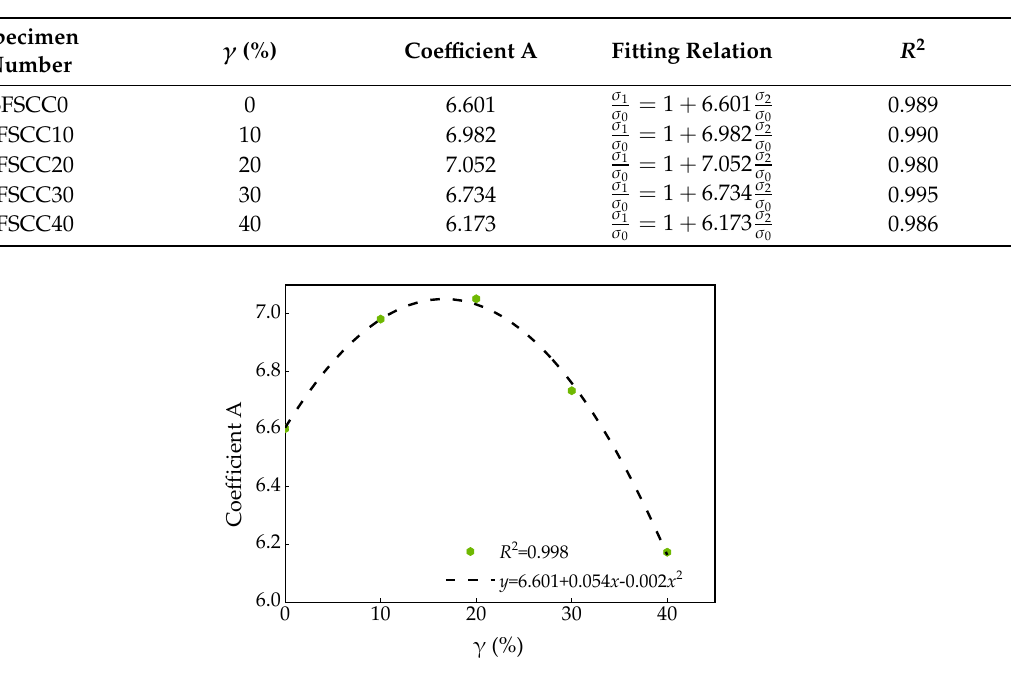
Figure 14. Relationship between coefficient A and FA substitution rate γ.